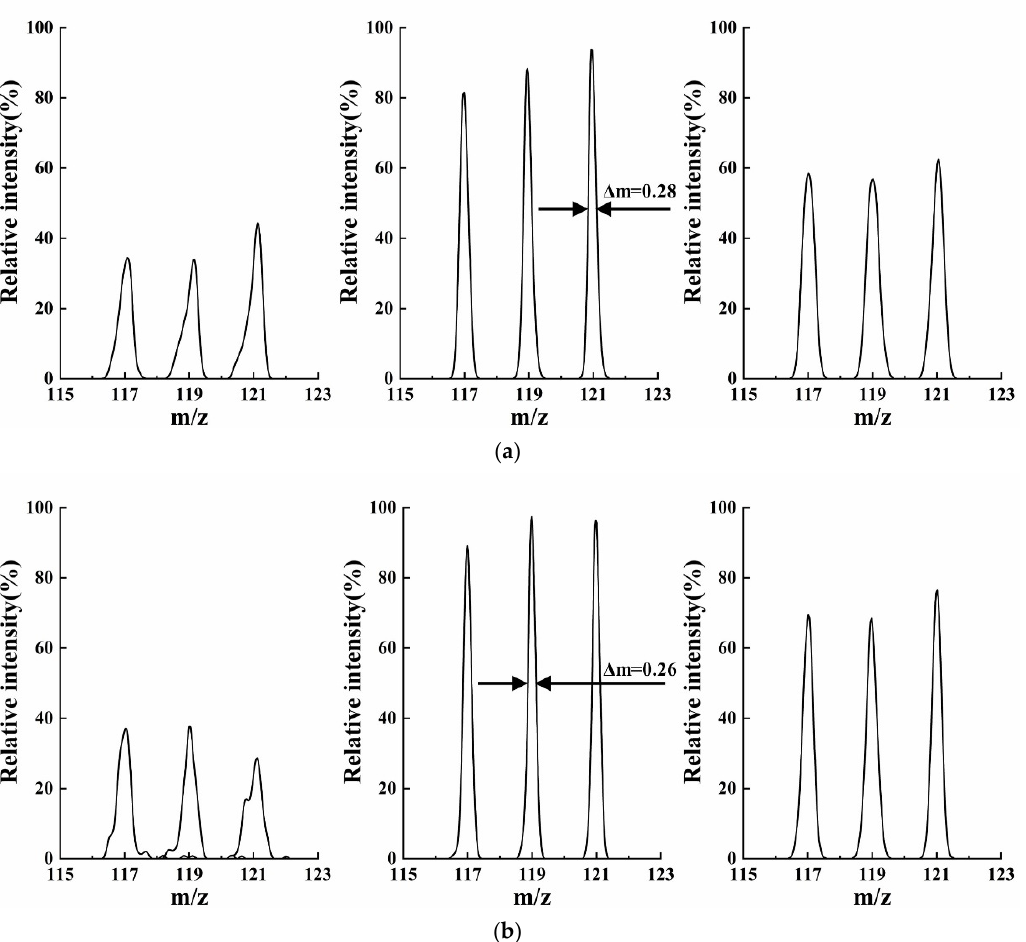
Figure 3. Mass spectrum when r/r x = 2/1, 2/1.4, and 2/2 with Δ r y kept 0.75 mm. ( a ) 2-slit model; ( b ) 4-slit model. Not only poor resolutions but also lower intensity and even distortion were observed when field radius r x was too big or too small.